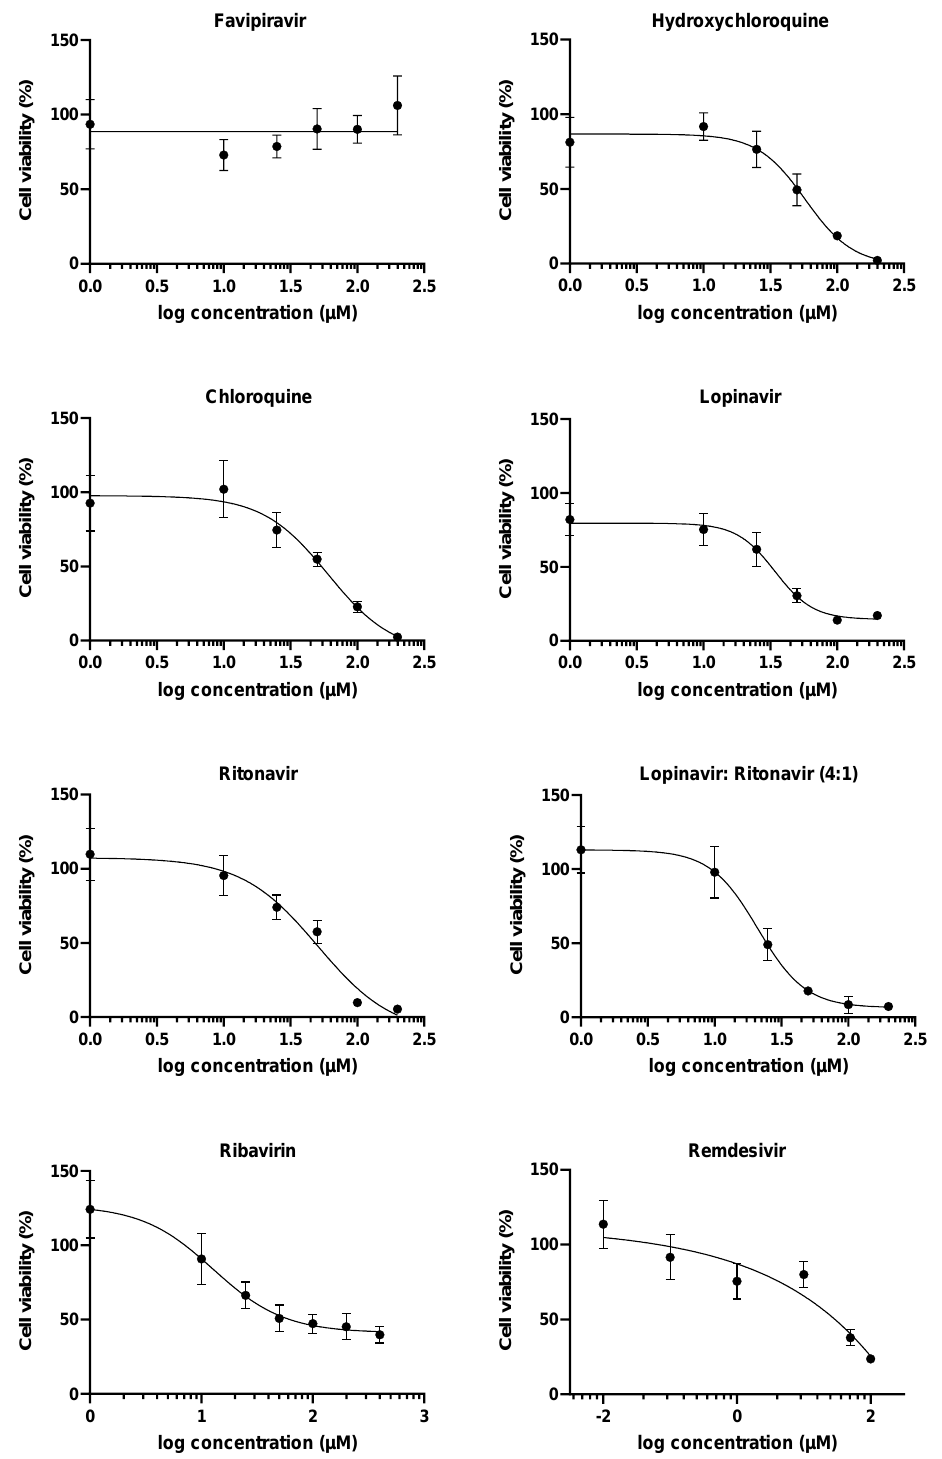
Figure 1. Cell viability curves for the determination of the CC 10 after 24 h exposure of transduced Dubca cells overexpressing human Panx1 to the drug panel. A sigmoidal curve was fitted by means of non-linear regression using GraphPad ® Prism to determine the CC 10 value. Data are expressed as mean ± standard deviation ( N = 3, n = 4) and visualised in separate graphs per drug.